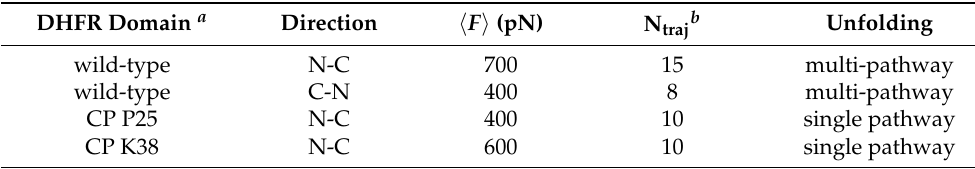
Table 3. Summary of ClpY ∆ I-SP simulations